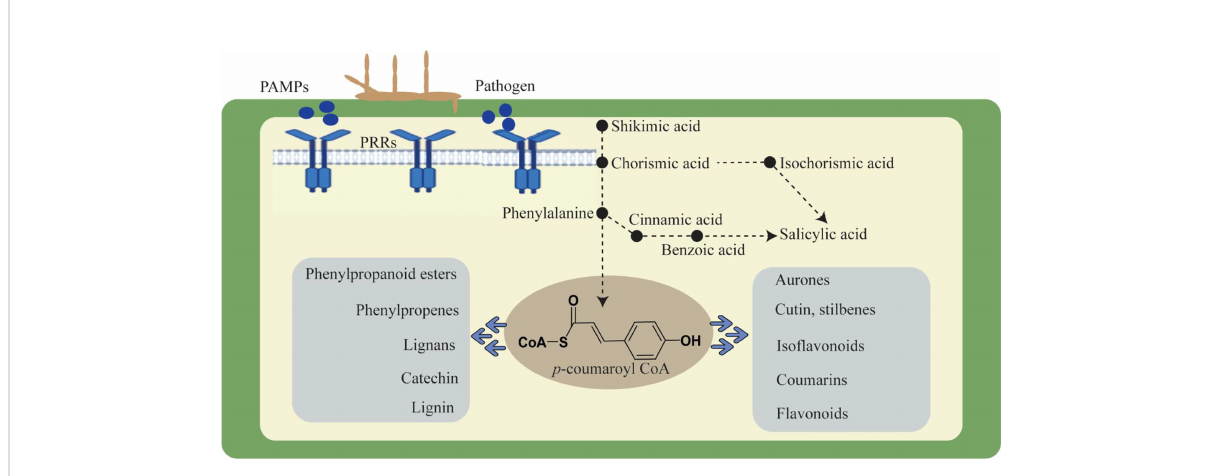
FIGURE 1 Cell wall dynamics during pathogen invasion and role of phenylpropanoid pathway in plant